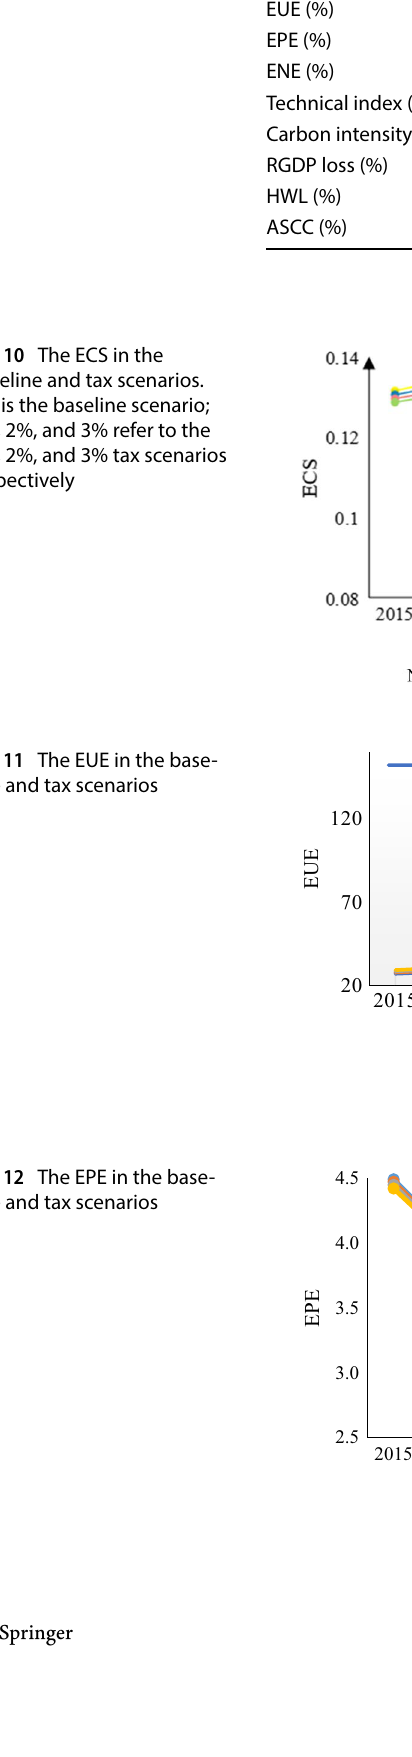
Table 9 The results of the sensitivity analysis in 2030 at the 1% tax